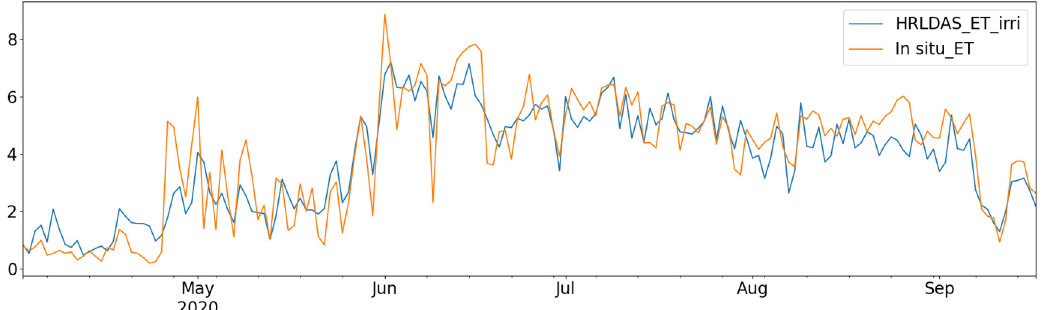
Figure 9. A comparison of HRLDAS ET and ground-observed ET in 2020 growing season, averaged over three sites inside Nebraska.